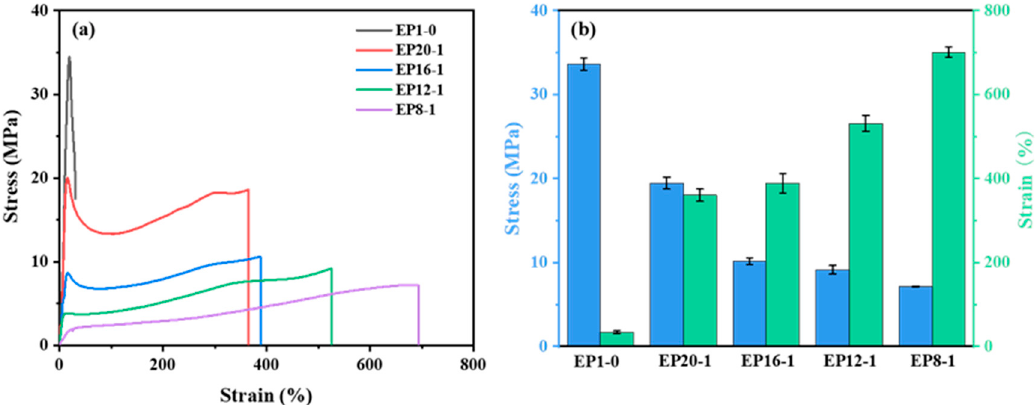
Figure 8. Strain-Stress curves ( a ) and statistics of Strain-Stress curves ( b ) of EPx samples.